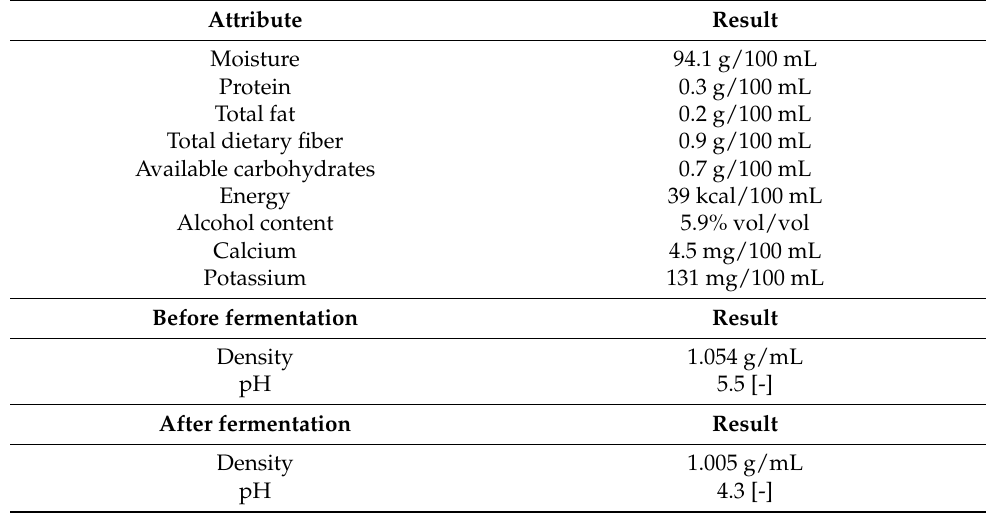
Table 8. Proximal analysis, ethanol content, calcium, potassium concentration and parameters before and after fermentation of prototype